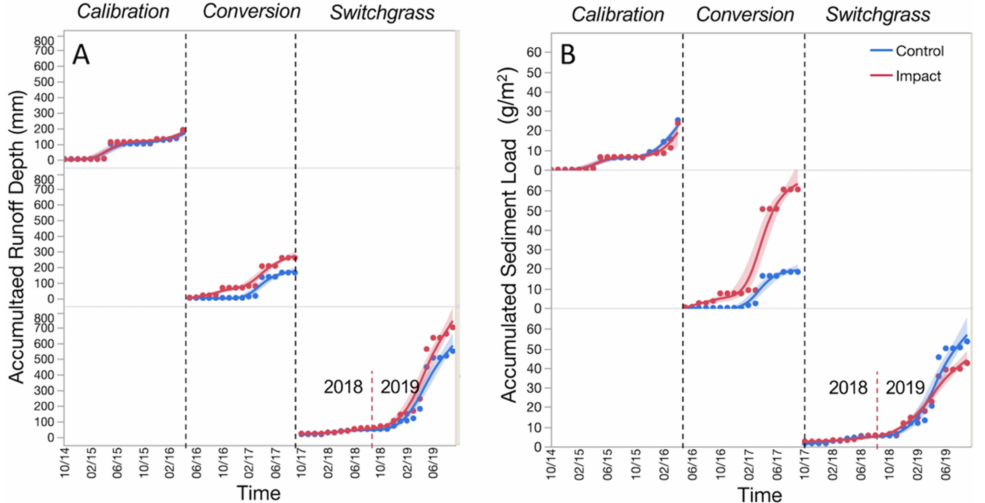
Figure 4. Comparison of accumulated runoff ( A ) and sediment load ( B ) between the Impact Water- shed and the Control Watershed for each